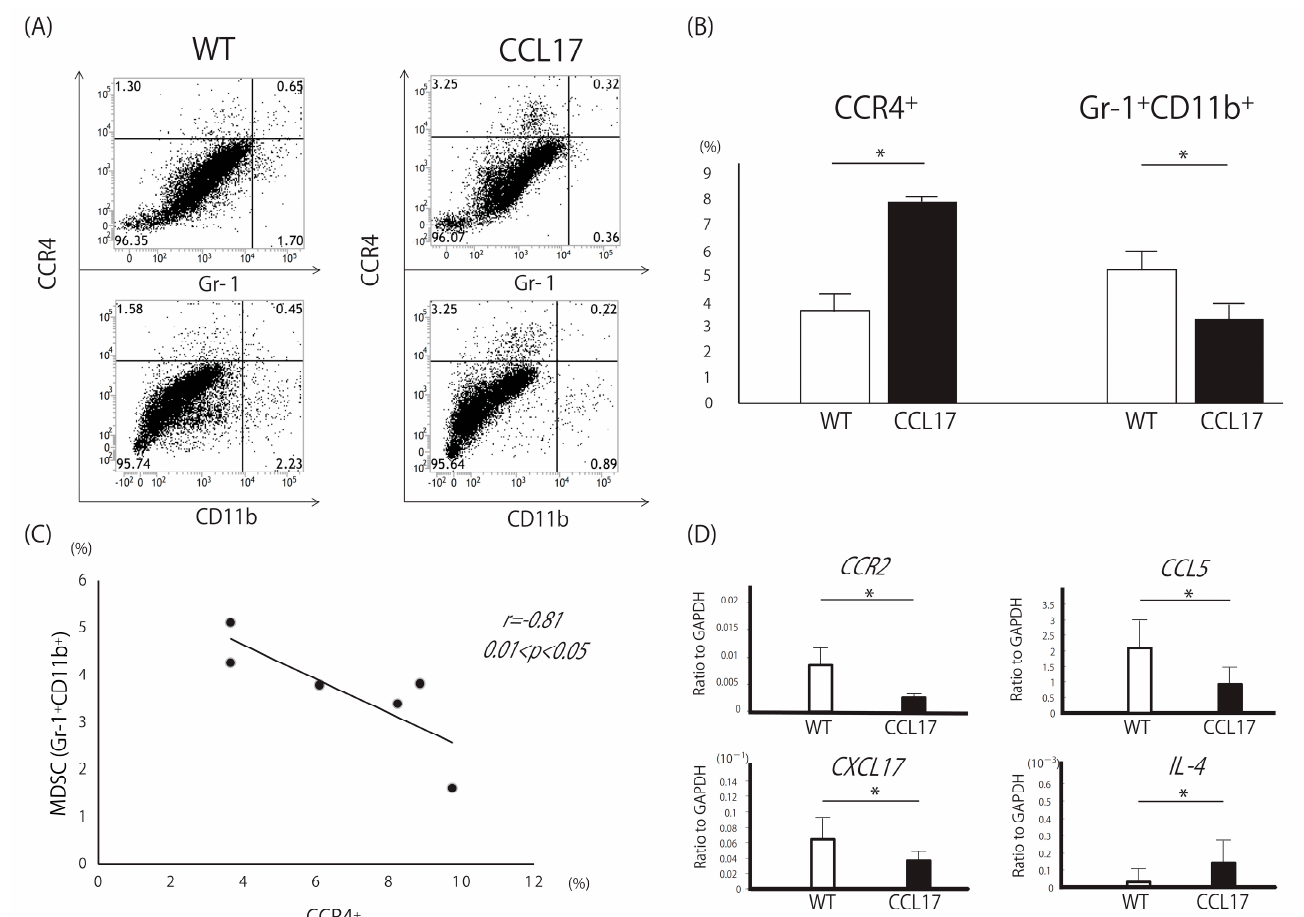
Figure 4. Decreased Myeloid-derived suppressor cells (MDSCs) in CCL17 transgenic (TG) mice. MDSCs are defined as CD11b + Gr-1 + in mice. CCR4 is expressed by Tregs and Th2 cells. Expression levels of CCR2 , CCL5 , and CXCL17 , which are all related to MDSCs, and IL-4 , which is produced by Th2 cells, were evaluated by quantitative reverse transcription-PCR in skin tumors from wild-type (WT) and CCL17 TG mice. ( A ) Representative flowcytometric images showing the frequency of CCR4 + cells, Gr-1 + cells − , and CD11b + cells. ( B ) The frequency of CCR4 + cells was significantly higher in CCL17 TG mice, while the frequency of CD11b + Gr-1 + cells was significantly lower compared with that of WT mice, respectively. ( C ) There is a negative correlation between the frequency of CCR4 + cells and that of CD11b + Gr-1 + cells. ( D ) Expression levels of CCR2 , CCL5 , and CXCL17 mRNA were significantly downregulated in CCL17 TG mice, while IL-4 mRNA levels were significantly upregulated in CCL17 TG mice compared with those in WT mice. * p < 0.05 WT versus CCL17 TG mice.